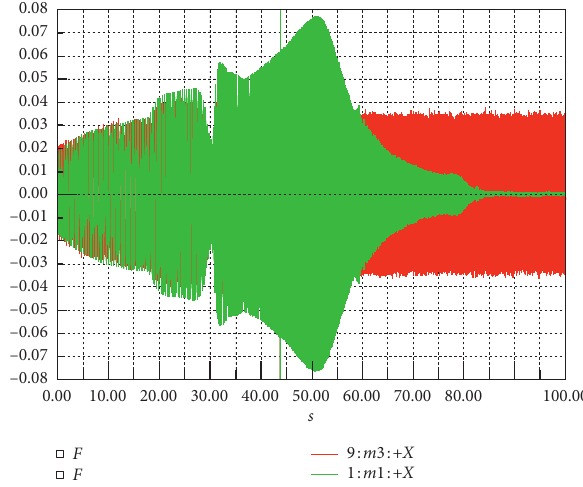
Figure 15: X -direction acceleration